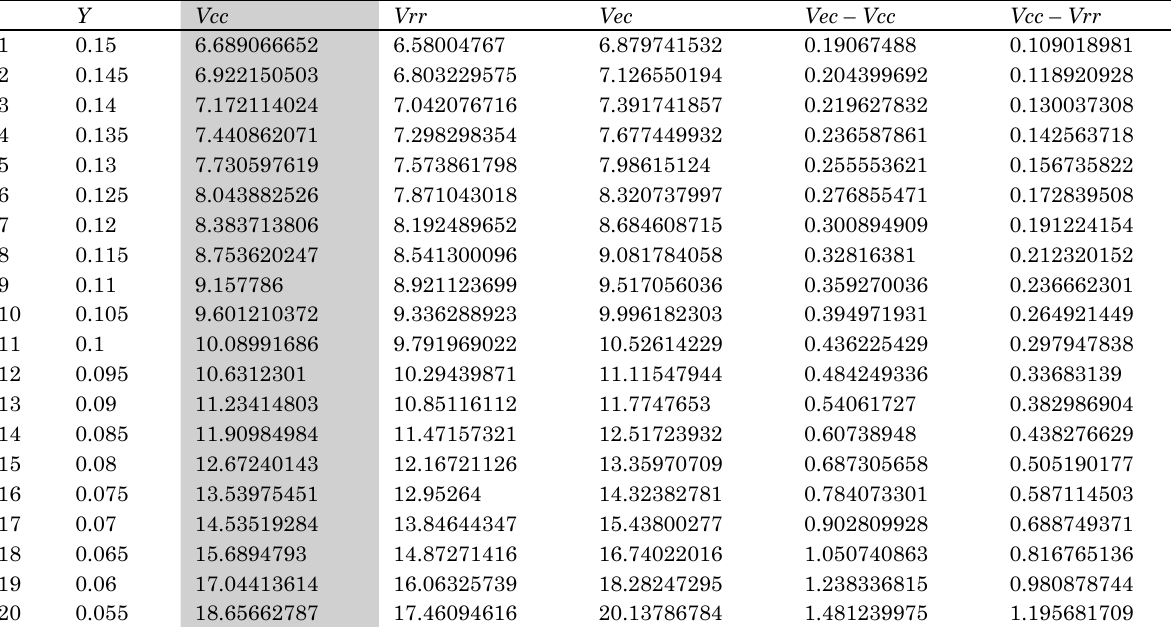
table 7. comparison between DD models and cyclical capitalization